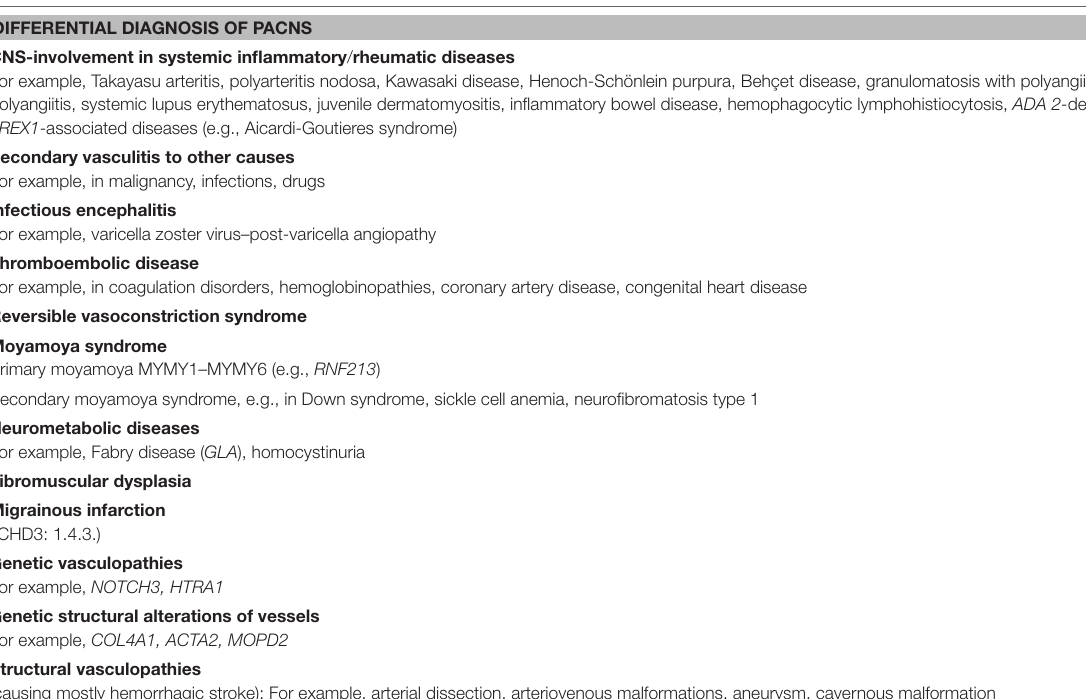
TABLE 2 | Differential diagnosis of